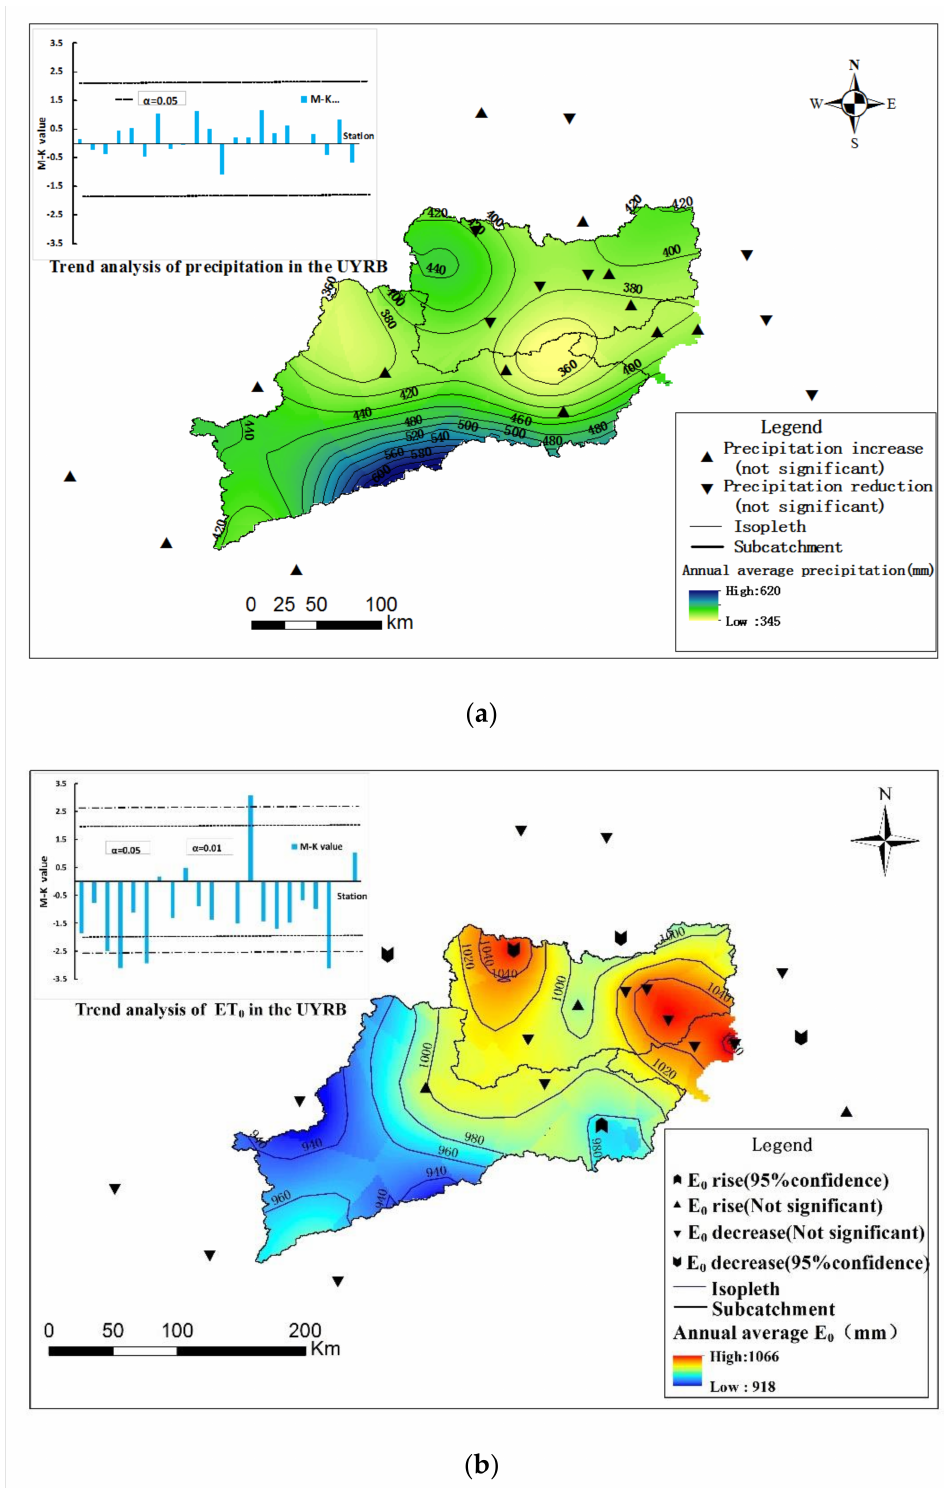
Figure 3. Trend analysis of precipitation ( a ) and potential evapotranspiration ( b ) in the UYRB. The inset shows the Z values of Mann–Kendall